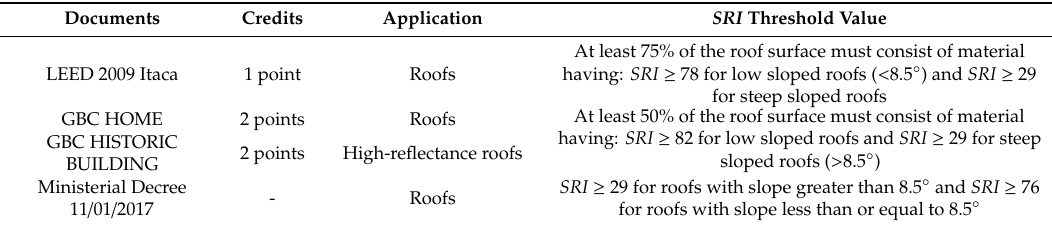
Table 3. Italian voluntary protocols and